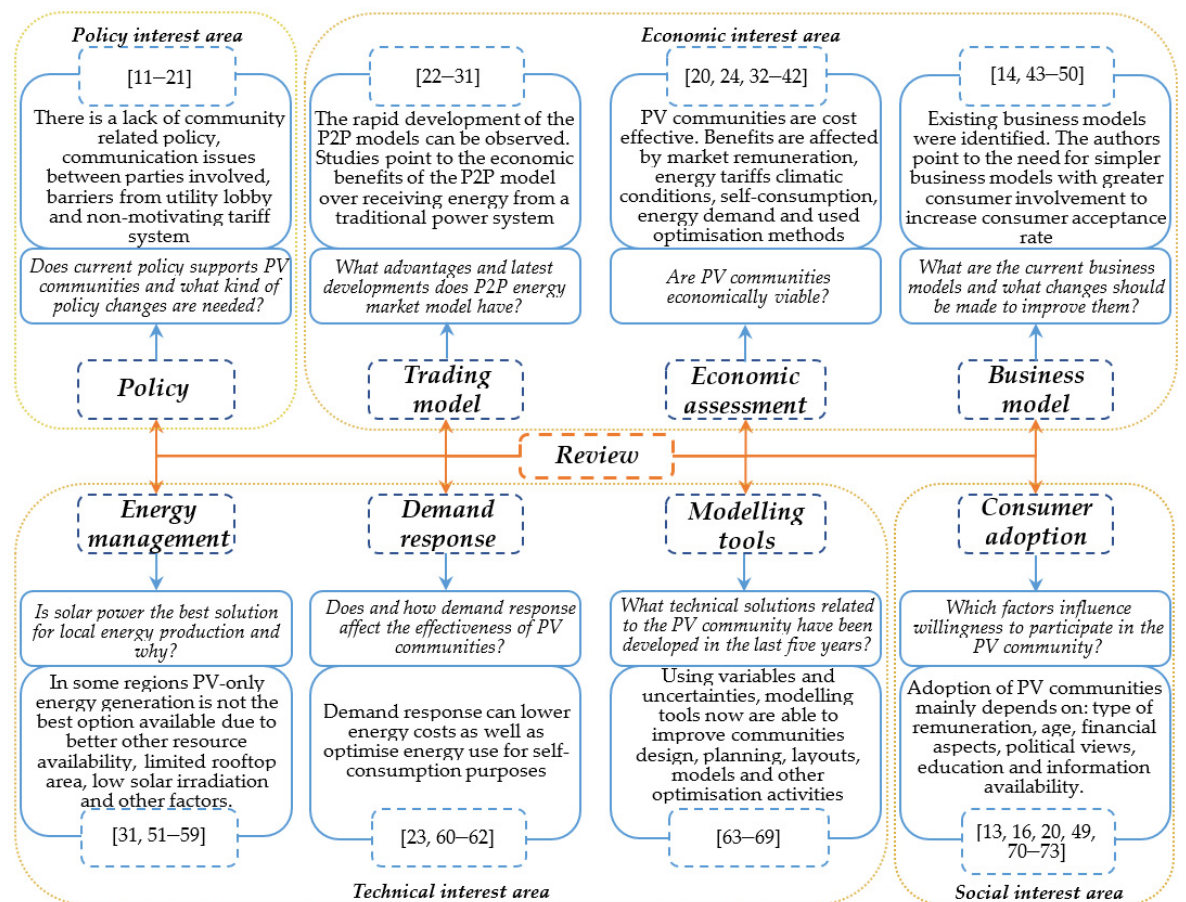
Figure 4. Literature review results.